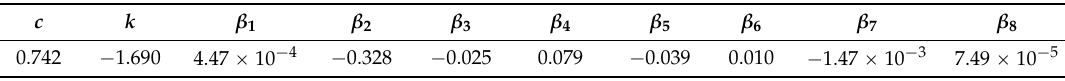
Table A3. Parameters of the optimized aspheric front